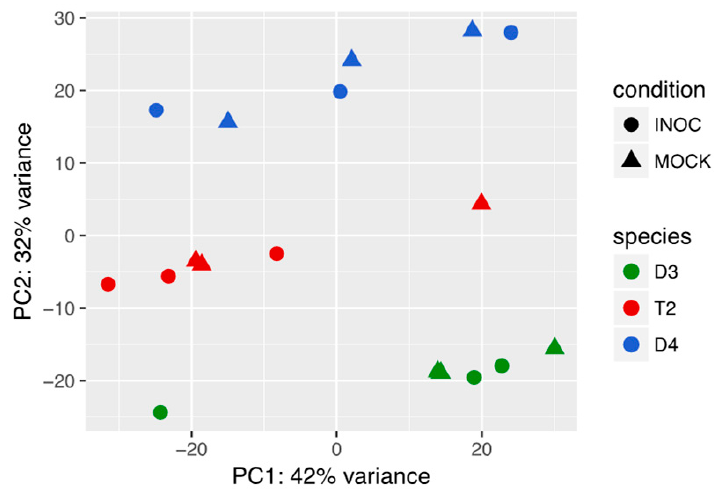
Figure 1. Principal component (PC) analysis of all D3 ( Glycine tomentella ), D4 ( Glycine syndetika ), and T2 ( Glycine dolichocarpa ) samples, conducted using rlog transformed expression values for the top 500 heterogeneously expressed genes across all samples. ‘INOC’ indicates samples inoculated with rhizobia; ‘MOCK’ indicates control samples that were mock-inoculated.